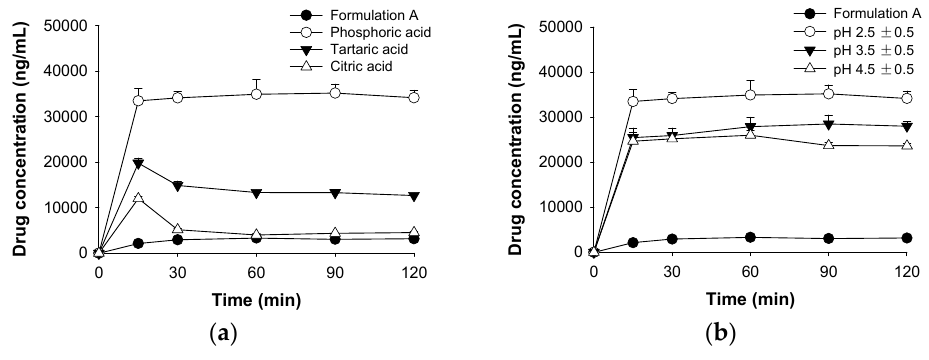
Figure 4. The effects of ( a ) acidifiers (Formulation A ( ● ); phosphoric acid ( ○ ), tartaric acid ( ▼ ), citric acid ( △ )) and ( b ) pH modification (Formulation A ( ● ); pH 2.5 ( ○ ), pH 3.5 ( ▼ ), pH 4.5 ( △ )) on inhibition of raloxifene hydrochloride precipitation in simulated intestinal fluid (pH 6.8) (means ± SDs, n = 3).